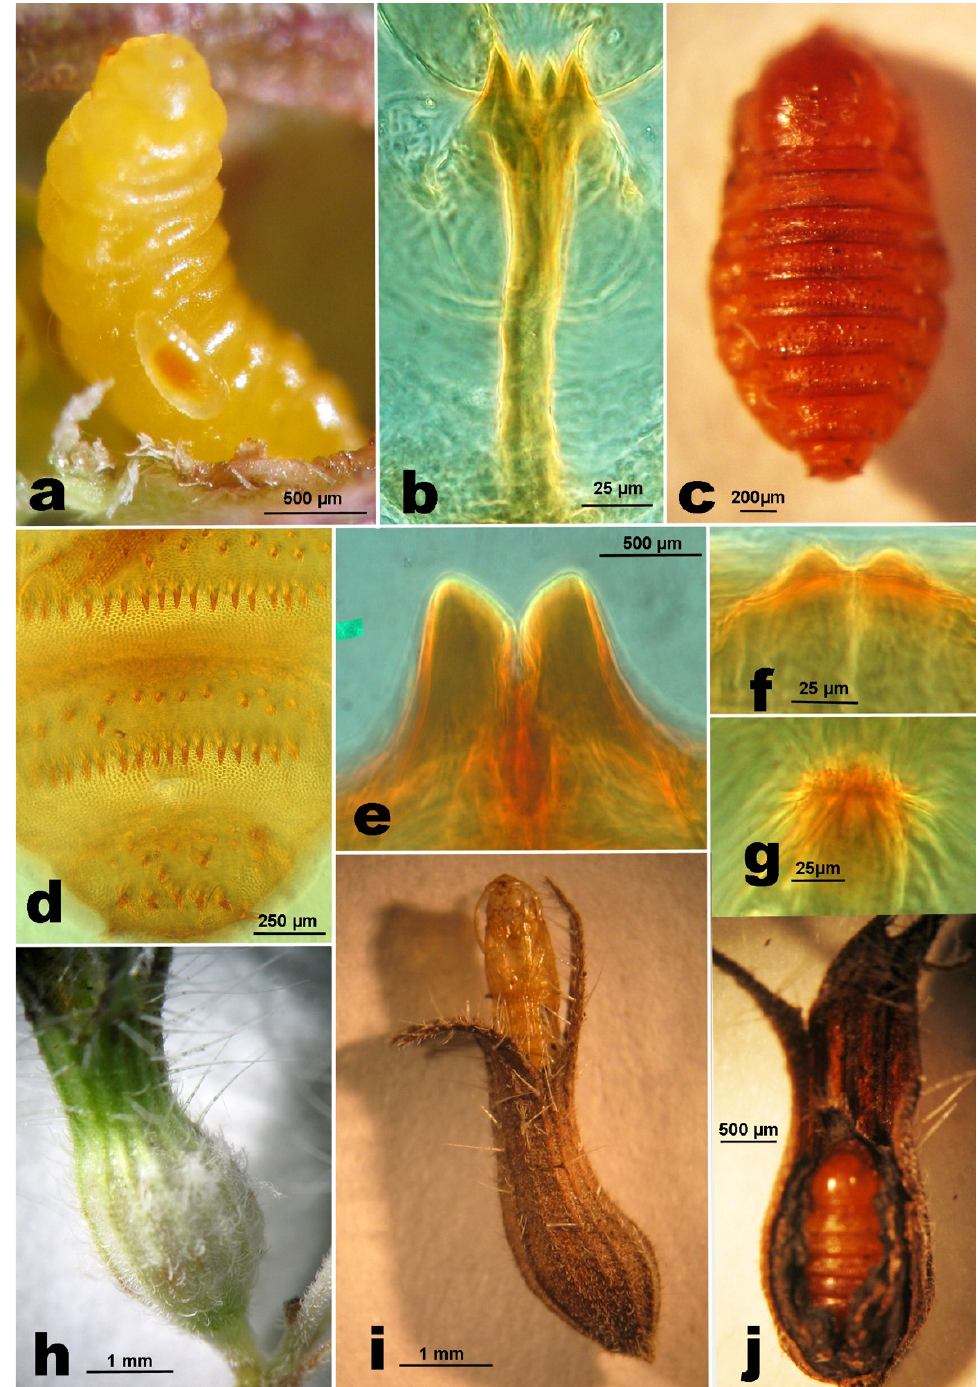
Figure 4. Asphondylia rivelloi . ( a ). Last instar larva, on it is a visible larva of an ectoparasitoid. ( b ). Spatula of the same. ( c ). Pupa. ( d ). Distal abdominal segments of the same, dorsal view. ( e ). Antennal horns. ( f ). Upper frontal horns. ( g ). Lower frontal horns. ( h ). Flower gall. ( i ). Flower gall with the pupal case of the emerged midge. ( j ). Flower gall opened showing an overwintering pupa.